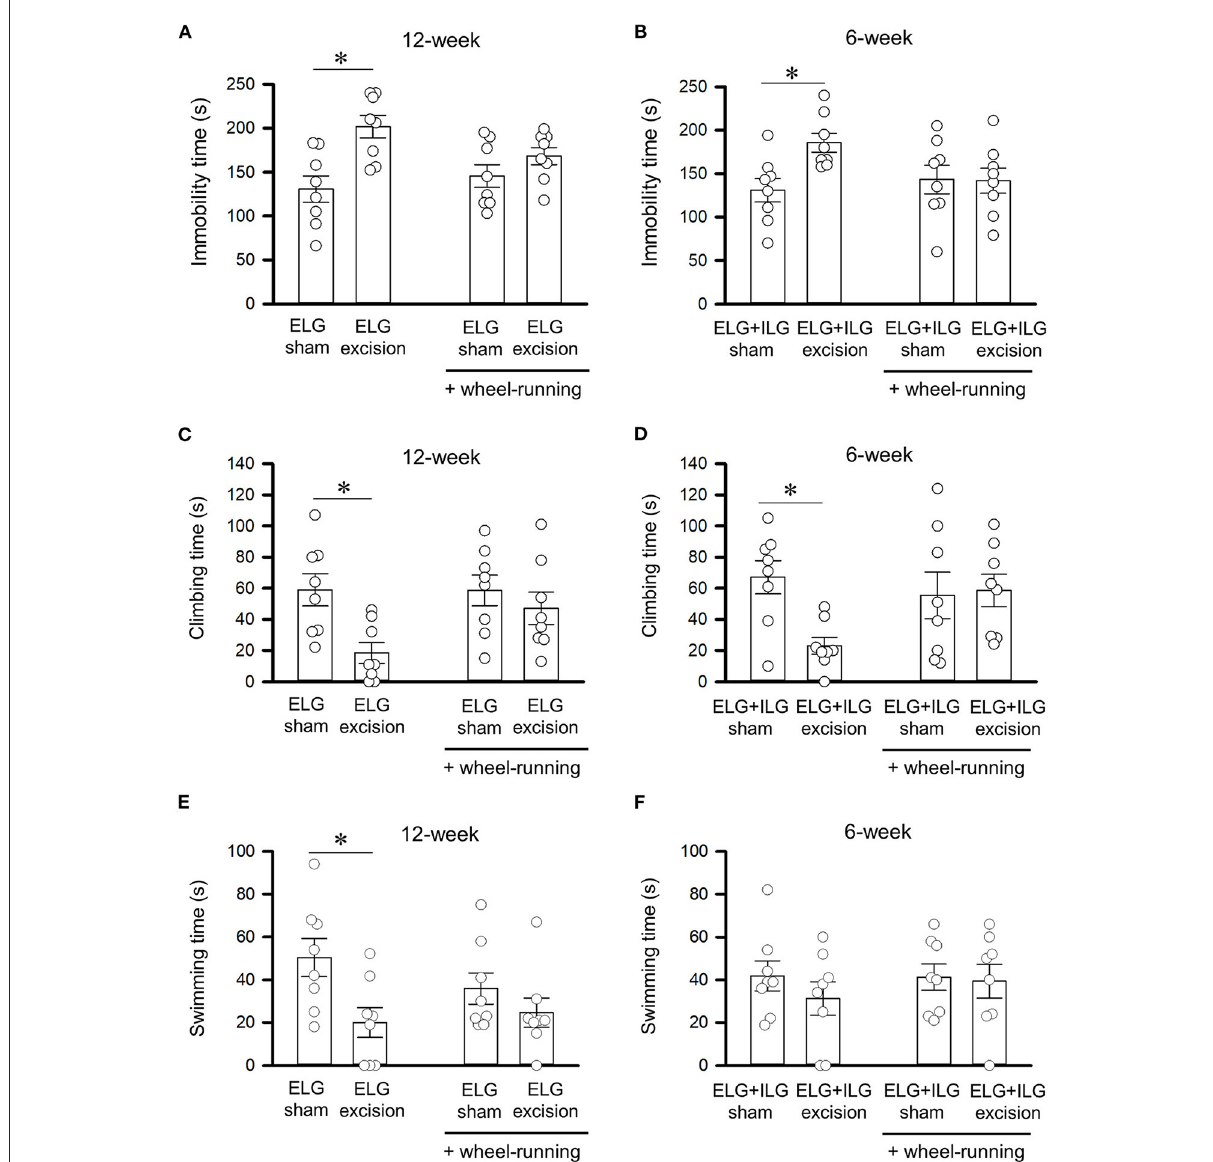
FIGURE5 Effect of voluntary wheel-running on behavioral performance in the forced swim test. Total times of immobility (A,B) , climbing (C,D) , and swimming (E,F) for 4min durations in the forced swim test were observed after wheel-running for 3 days, as shown in Figure 4B. Tests were performed with ELG excision and sham-operated mice at 12 weeks after surgery (A,C,E) , and with ELG + ILG excision and sham-operated mice at 6 weeks after surgery (B,D,F) . Each column and the corresponding vertical bar represent the mean ± SEM ( n = 8); open circles indicate individual values. * P < 0.05 vs . the sham-operated group.